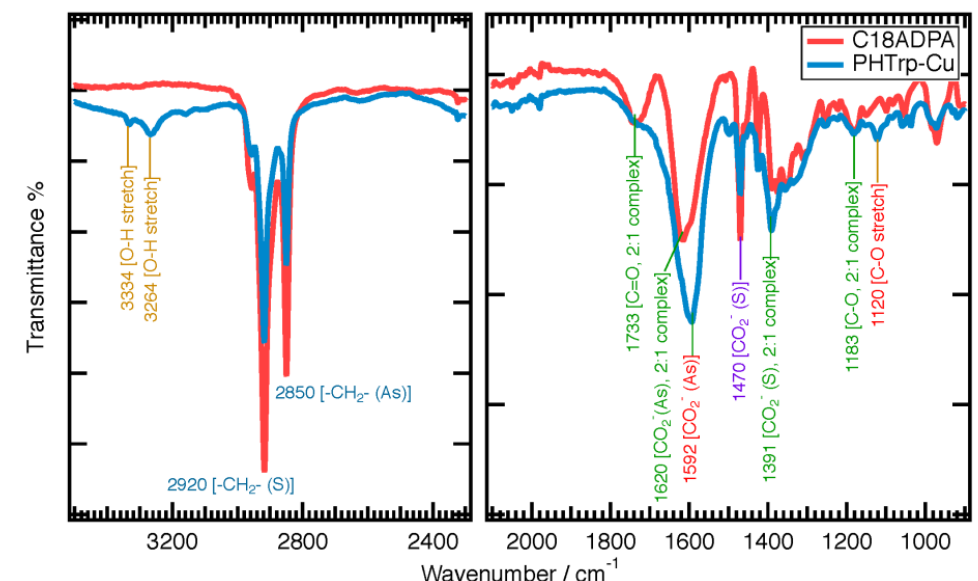
Figure 6. L-XRD data of the C18ADPA hydrogel and the PHTrp-Cu hydrogel.